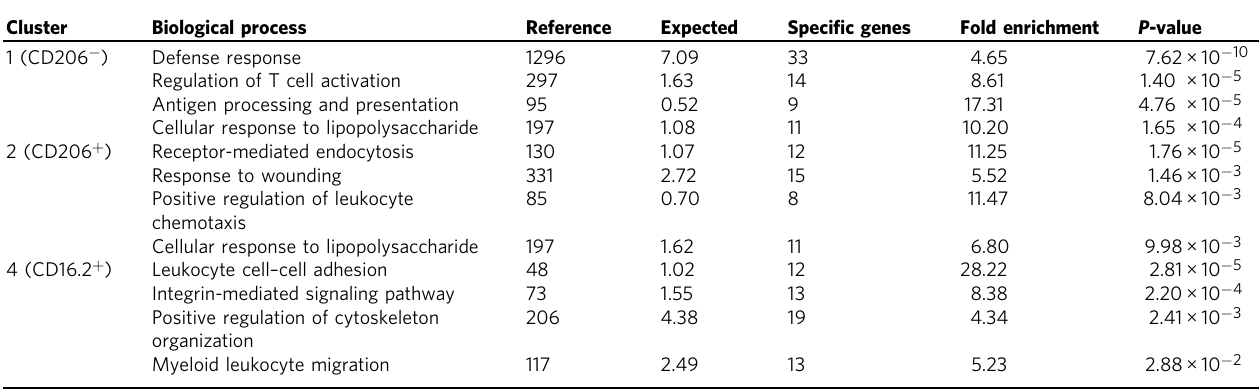
Table 1 Gene Ontology analysis of the transcriptomic pro fi les of IM subpopulations Cluster Biological process Reference